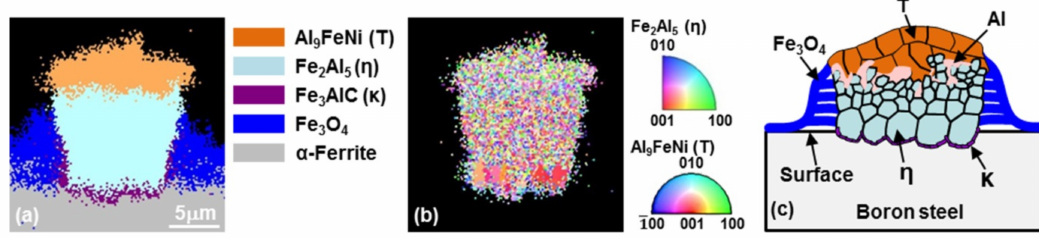
Figure 8. ( a ) EBSD phase map; ( b ) IPF analysis (Al 9 FeNi (T), Fe 2 Al 5 ( η ), Fe 3 AlC ( κ ) phase); and ( c ) schematic diagram of the reaction layer hot-dipped for 10 s.